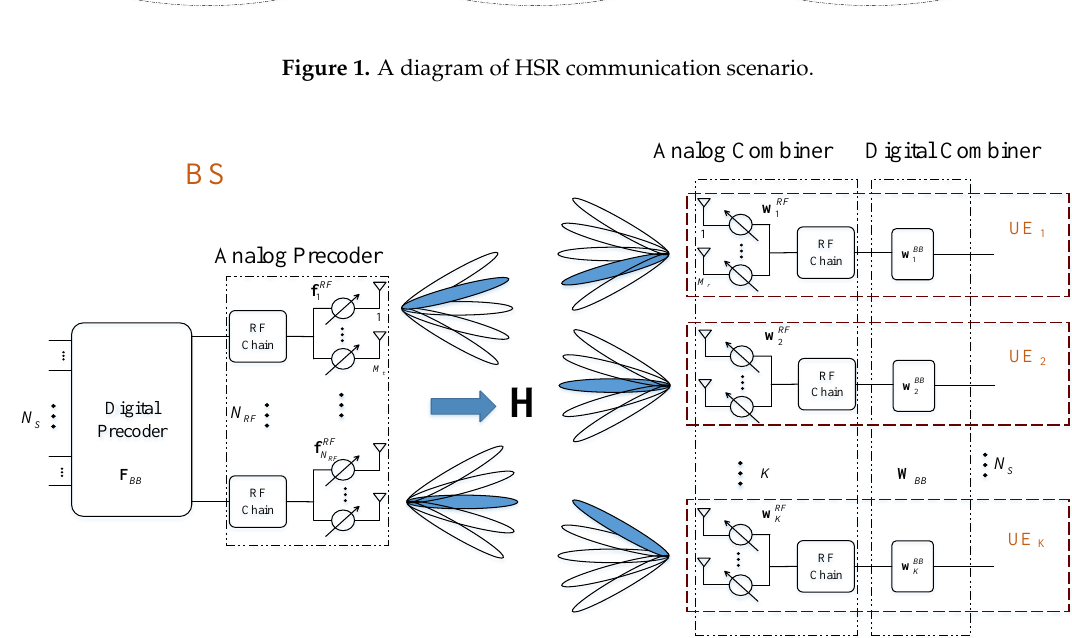
Figure 2. Block diagram of the mmWave communications system with partial connection